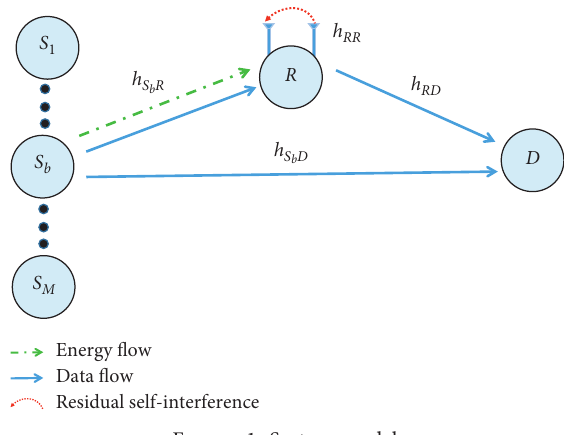
Figure 1: System model.